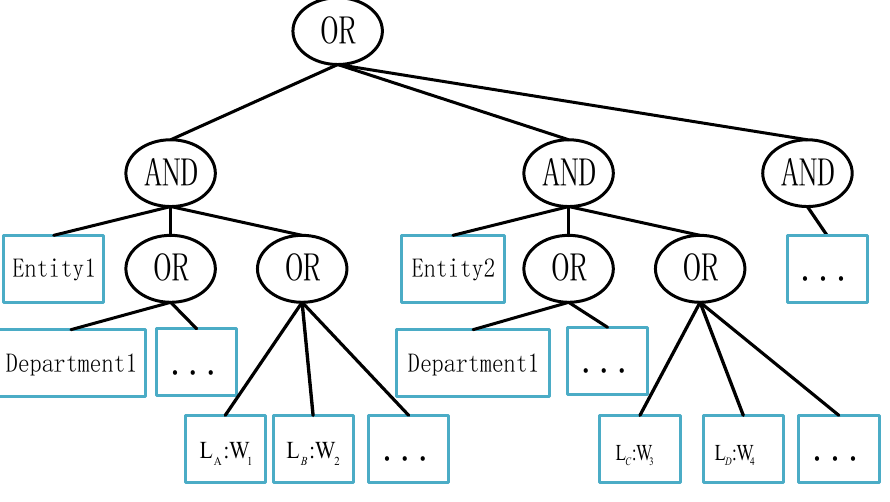
Figure 2. The attribute-weighted access tree.